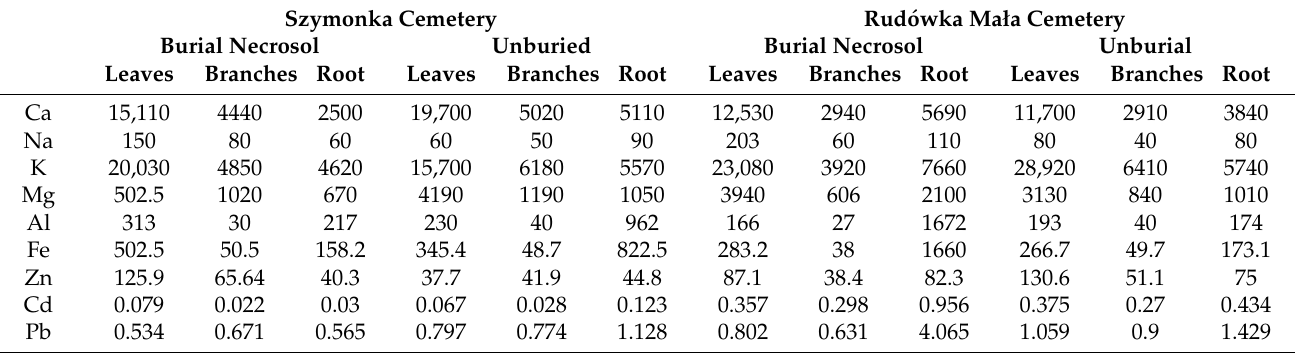
Table 5. Chemical composition of S. vulgaris , growing on burial and non-burial soils (mg · kg − 1